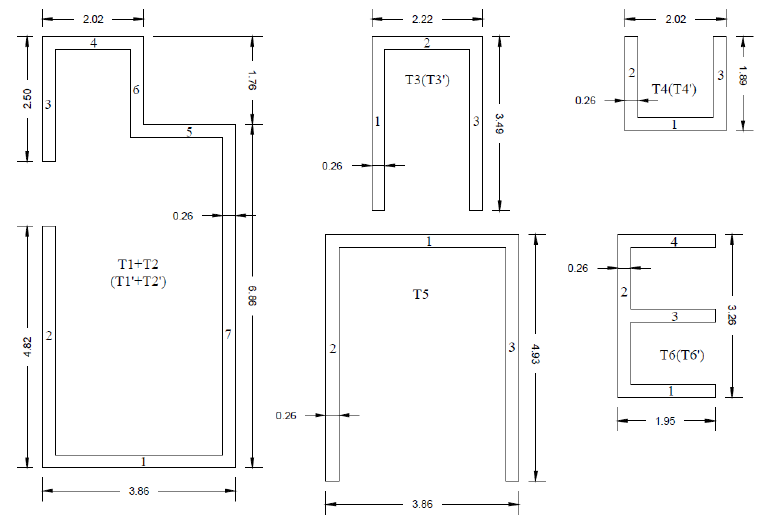
Figure 14. Geometry of RC cores.